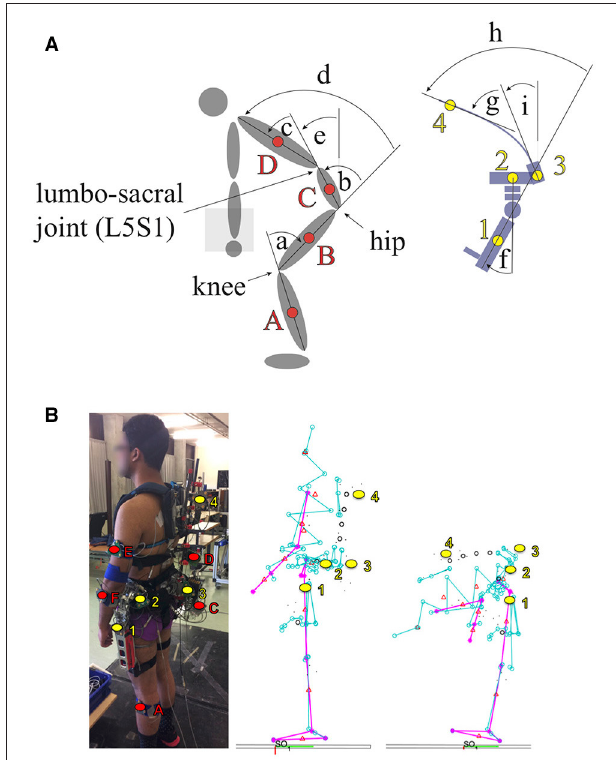
FIGURE 8 | Angle definitions for the human and the exoskeleton (A) . Knee angle (a), hip angle (b), lumbarangle(c), trunk angle (d), pelvis inclination (e), exo hip angle (f), exo lumbar angle (g), exotrunkangle(h), exo pelvis inclination (i), Measurement setup (B) . Subject equipped with the exoskeleton and markers to track the position and orientation of different body parts (red). The position and orientation of the lower leg (A), upper leg (B, not visible in this photograph), the pelvis (C), the trunk (D) the upper arm (E), and the lower arm (F) are tracked. Additionally, the exoskeleton is equipped with marker clusters to track the exoskeleton (yellow) hip angle (1) the pelvis carbon fiber frame at the hip (2) the pelvis carbon fiber frame at the base of the spinal exoskeleton structure (3) top of the spinal exoskeleton structure (4). Various single markers were used to track individual parts of the exoskeleton, but are not further used in the analysis and therefore not further elaborated. The stick figures show a visualization of the tracking results. For the sake of clarity, the body markers (red) are not highlighted in this figures. In the middle the subject is standing upright. The pink lines represent body parts of the subject, while the turquoise color represents the exoskeleton structure. On the right, the subject is performing a stoop. Written informed consent was obtained from the participant to publish this